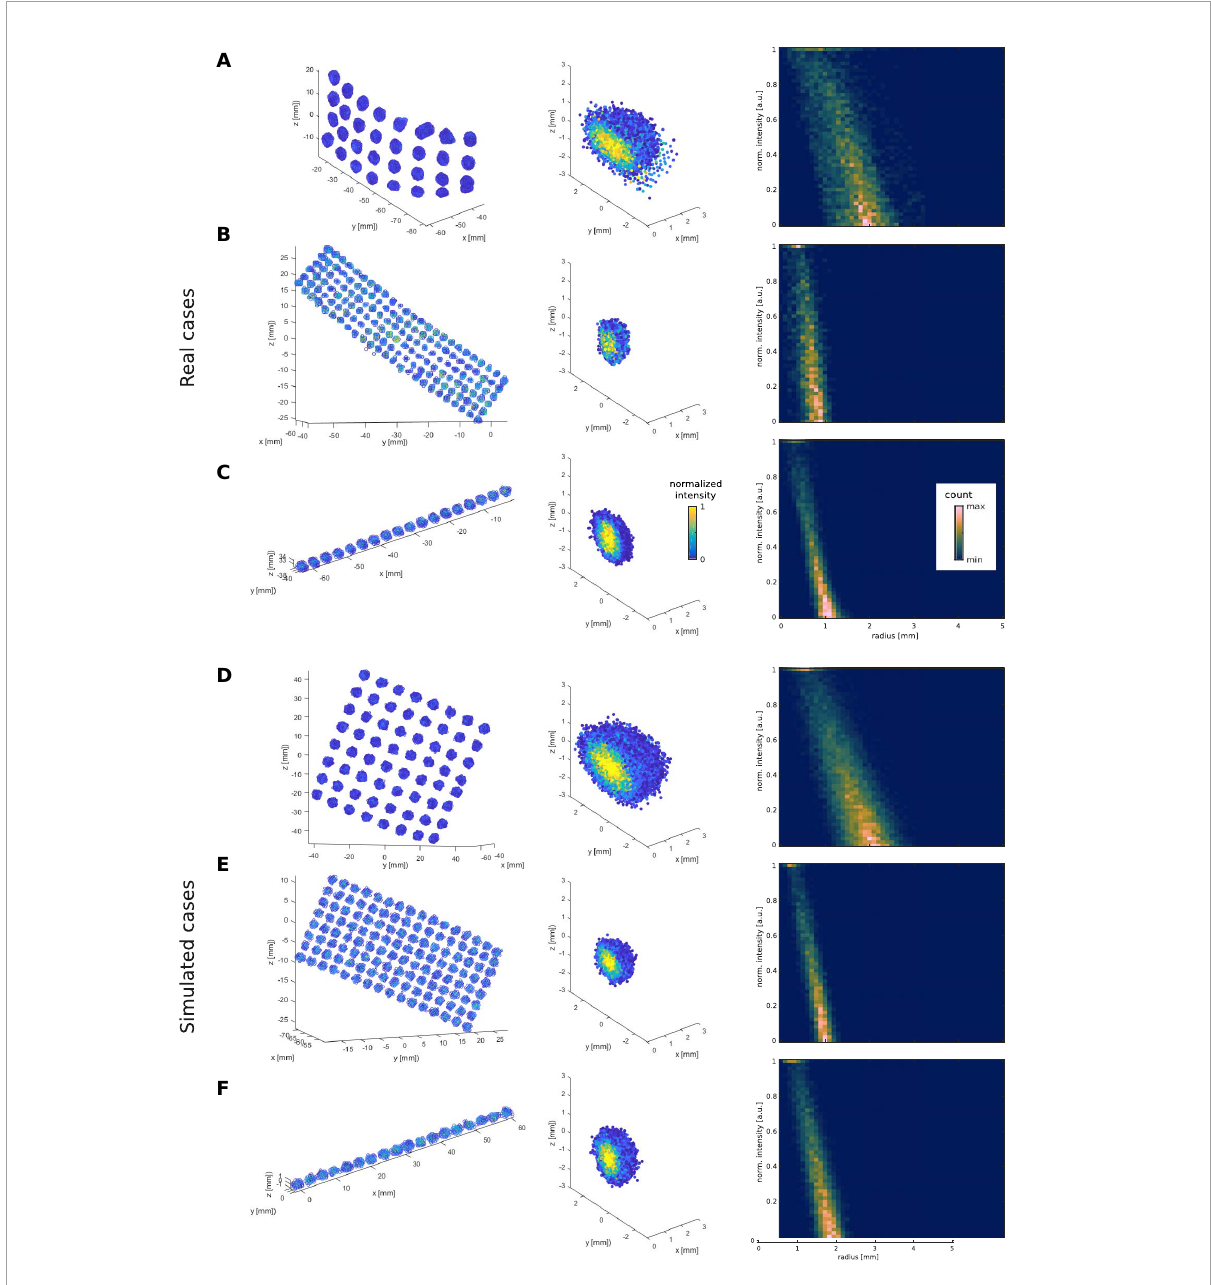
FIGURE7 Examples of real and simulated electrode CT artifacts and their 2D intensity-radius histograms. The three top rows show examples of real CT artifacts obtained from a 10 mm IED grid (A) , a 3 mm IED high-density grid (B) , and a 3 mm IED depth electrode array (C) . The three bottom rows (D–F) show simulated cases with noise levels that best fit the real ones above (present the highest correlation). The left column plots show the spatial distribution of the voxels’ artifacts. The middle column shows the same artifacts after all individual electrodes were recentered at the origin (0,0,0), and their principal axes (orthogonally to the cortical surface for grids) or main axes (connecting outer electrodes for depths) aligned to the z -axis. For visualization purposes, only half of the electrode voxels are shown. The right column plots show their respective intensity vs. radius histogram. For illustrative purposes (C,F) middle and right column plots were obtained from 10 depth electrodes in the corresponding patient, or 10 simulated depth arrays, and not only from the individual arrays shown on the left column.